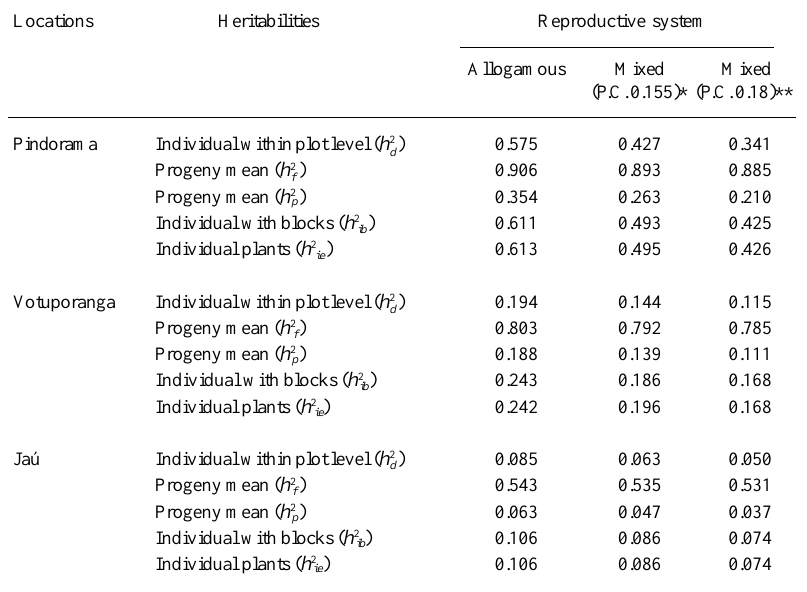
Table II - Heritability coefficients (species considered allogamous with a mixed reproductive system) associated with different effects in the selection methods for rubber production (RP) in three-year-old Hevea at three locations.